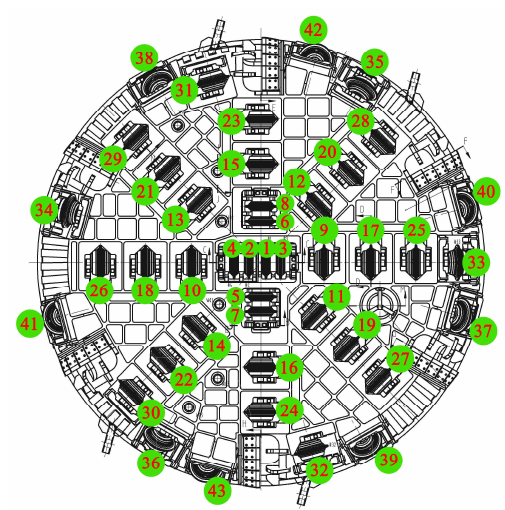
Figure 3. Cutter-head of double-shield TBM (Reprinted with permission from Refs. [30,31].)